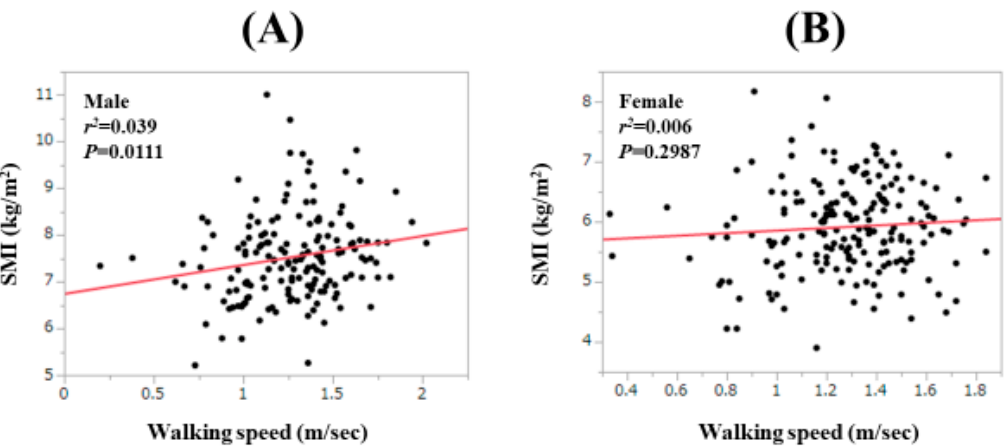
Figure 5. Correlation between the WS value and the SMI value in males ( A ) and in females ( B ).